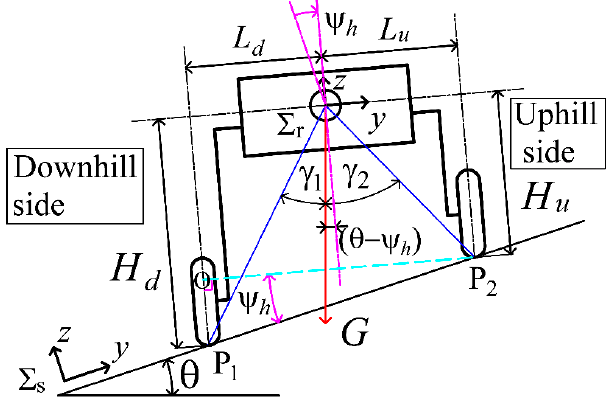
Figure 8. Mechanical mobile robot on a side slope.